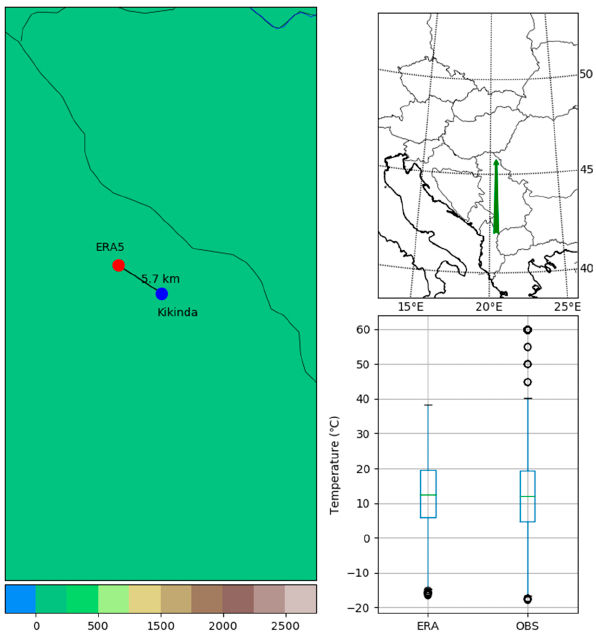
Figure 1. Altitude (m a.s.l.) and position of the Kikinda (Serbia) automated weather station (AWS).